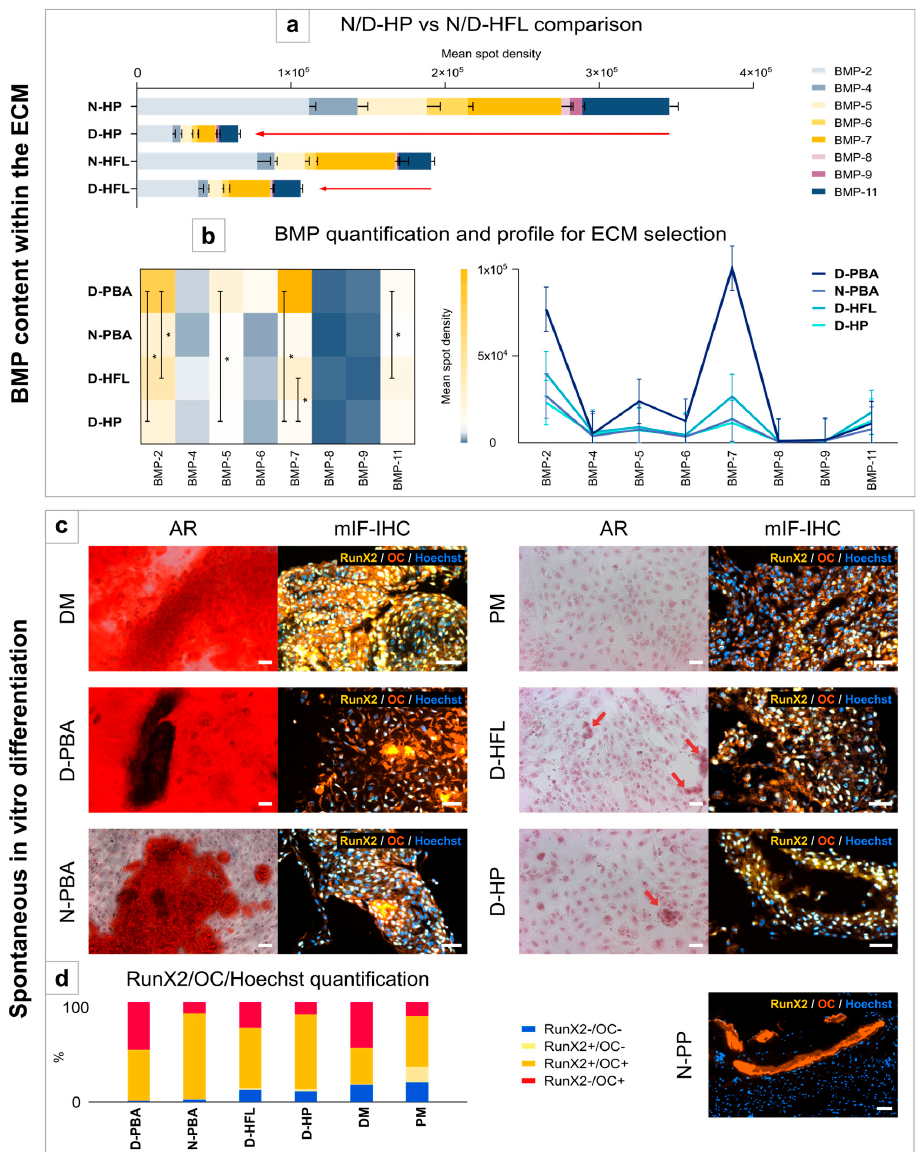
Figure 5. Evaluation of the osteoinduction potentials of ECMs via the BMP content in each matrix and spontaneous differentiation of PMSCs in vitro. The RayBio ® C-Series Human BMP Related Array 2 (Tebu-Bio, 126AAH-BMP-2–8, Le Perray-en-Yvelines, France) was used for the BMP quantification ( a , b ). First, the D-HFL membrane was compared with the periosteum via a stacked bars diagram of all types of BMP ( a ). Then, the BMP content was expressed according to each ECM with a heatmap and a profile graph ( b ). PMSC spontaneous differentiation was confirmed with AR staining and mIF-IHC for RunX2 and OC ( c ). This last experiment was quantified in order to increase the knowledge about the ECM impact on PMSC differentiation stage ( d ). This graph shows the relative content of cells labeled with RunX2 alone (RunX2+/OC-), RunX2 and OC (RunX2+/OC+), OC alone (RunX2-/OC+), or none of them (RunX2-/OC-). N/D-HP: native or decellularized human periosteum, N/D-HFL: native or decellularized human fascia lata, BMP: bone morphogenetic protein, D-PBA: decellularized porcine bone allograft, N-PBA: native porcine bone allograft, AR: Alizarin Red staining, mIF-IHC: multiplex immunofluorescence immunohistochemistry, OC: osteocalcin, DM: differentiation medium, PM: proliferation medium, and N-PP: native porcine periosteum. White scale bars: 50 µ m. T-bars: standard error of the mean (SEM), error bars: 95% confidence interval (CI), and *: p <